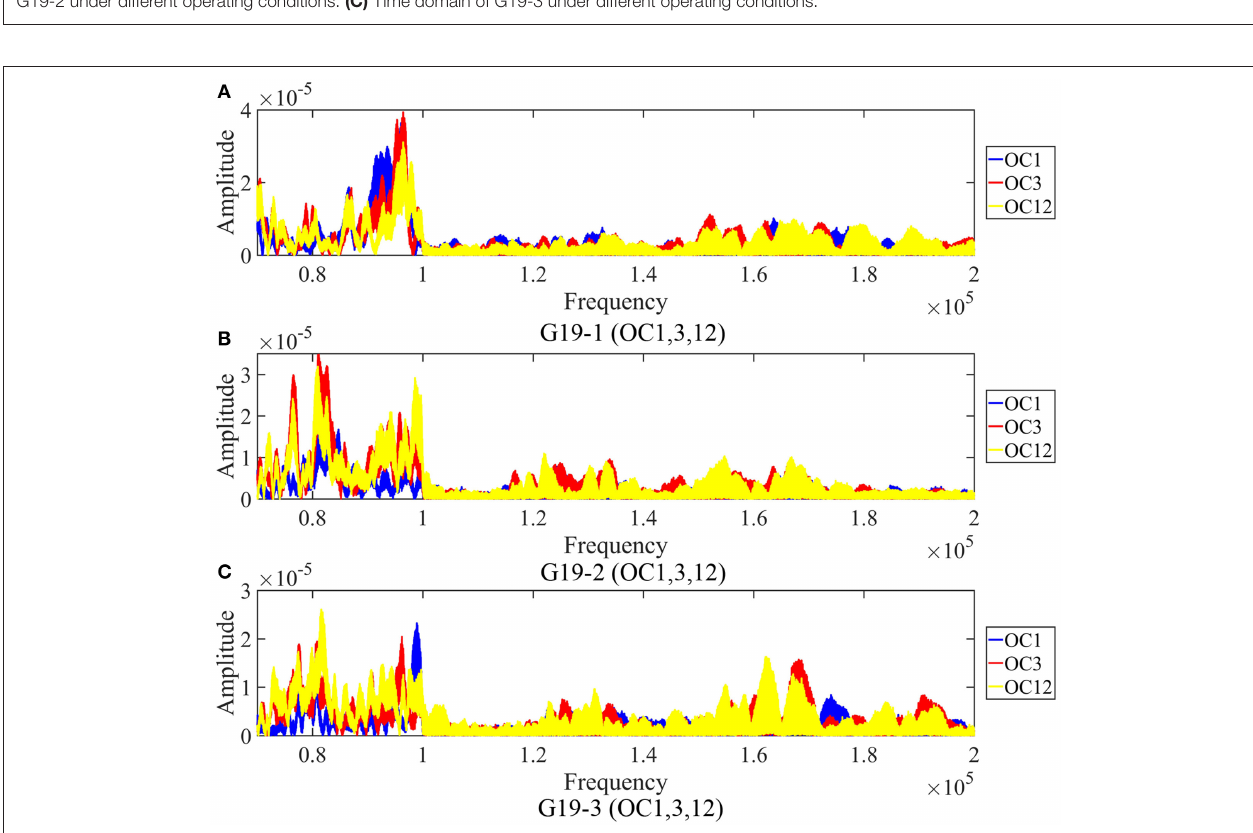
FIGURE 10 | Frequency-domain signal of G16 after testing under different operating conditions. (A) Frequency domain of G19-1 under different operating conditions. (B) Frequency domain of G19-2 under different operating conditions. (C) Frequency domain of G19-3 under different operating conditions.